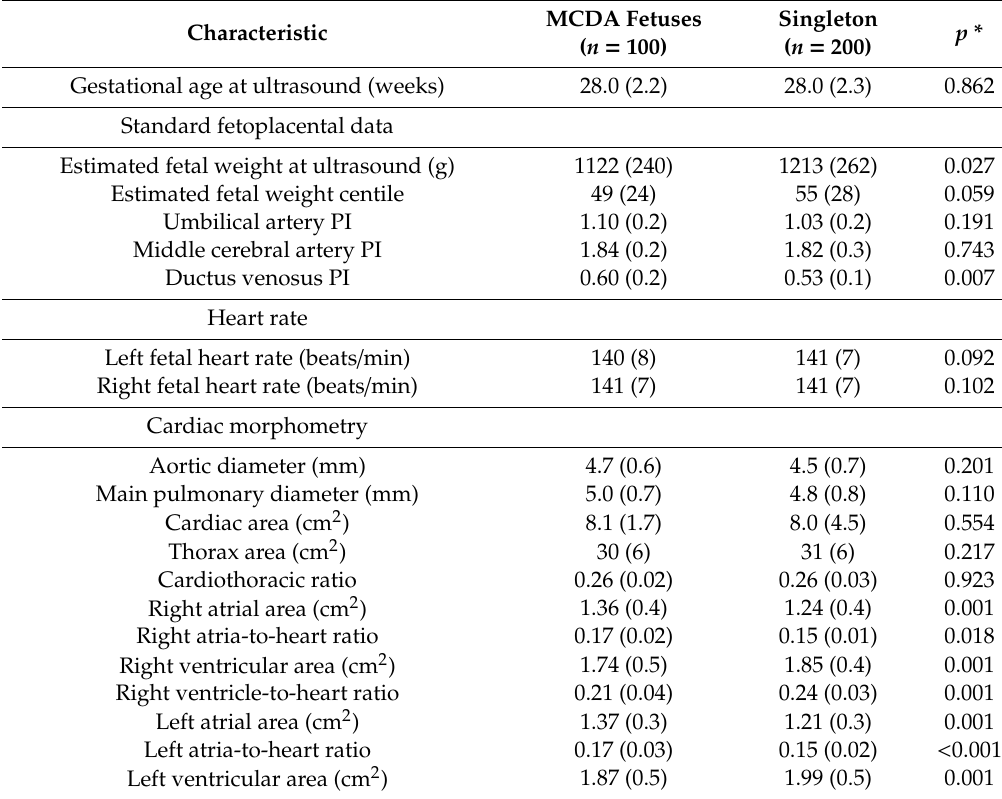
Table 2. Cardiac functional and structural parameters of 100 monochorionic diamniotic twin fetuses and 200 low-risk